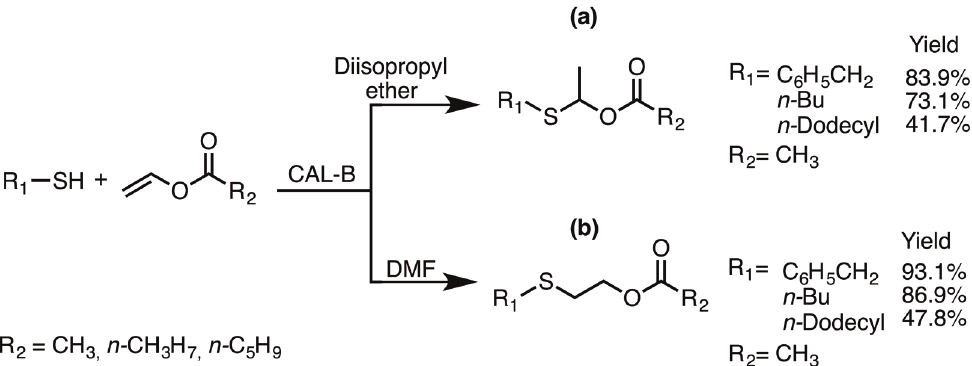
Figure 35 - Reactions of thiols with vinyl esters catalyzed by lipase, CAL-B: Markovnikov product ( a ) and anti-Markovnikov product ( b